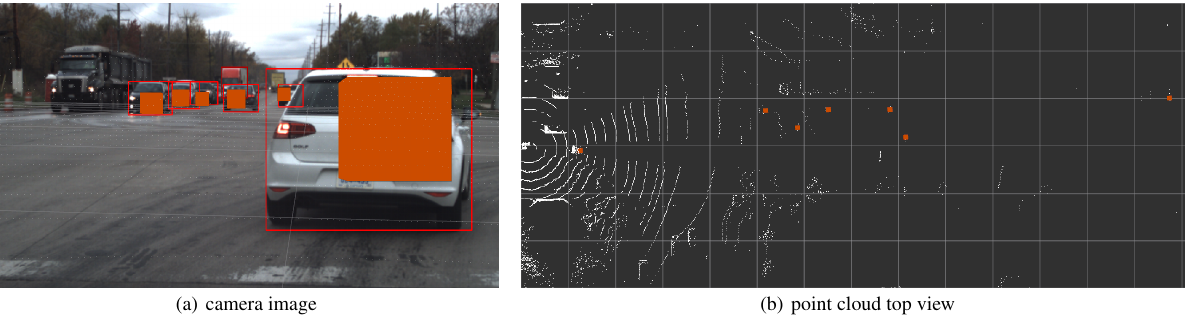
Figure 3. Object detection results on a junction. (a) Camera image overlayed with bounding boxes calculated by the CNN (red rectangles around vehicles) and 3D centroids projected into the image (orange cubes). (b) Top view of the Lidar point cloud (white dots) with calculated object centroids (orange cubes). Ego vehicle is located at the left boundary of the figure. Grid cells have a size of 10 by 10 meters.